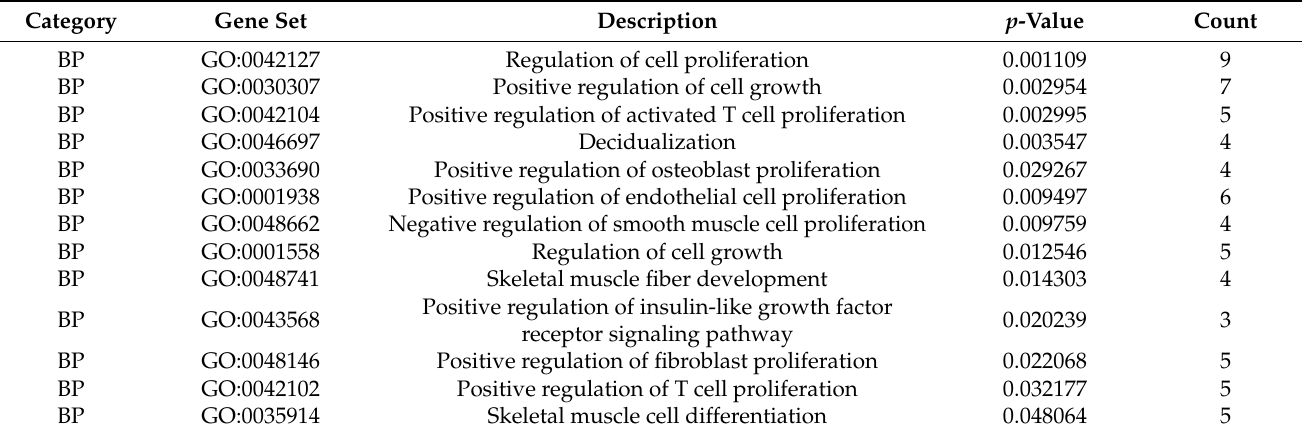
Table 4. Biological processes associated with skeletal-muscle-maturation- and hypertrophy-related DEGs in Ovis aries